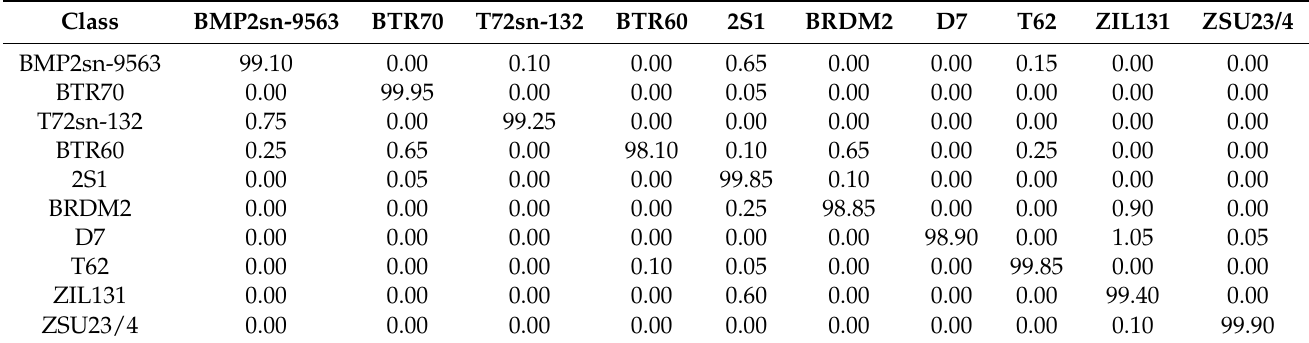
Table 3. The confusion matrix of the proposed network instance (recognition rate: